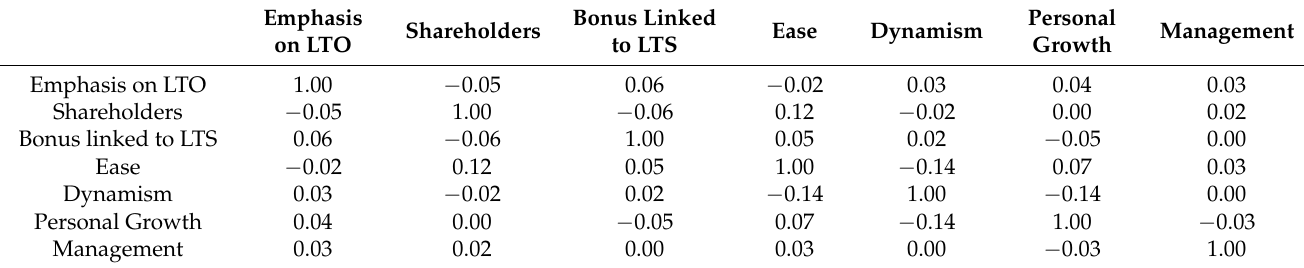
Table 4. Correlation matrix.